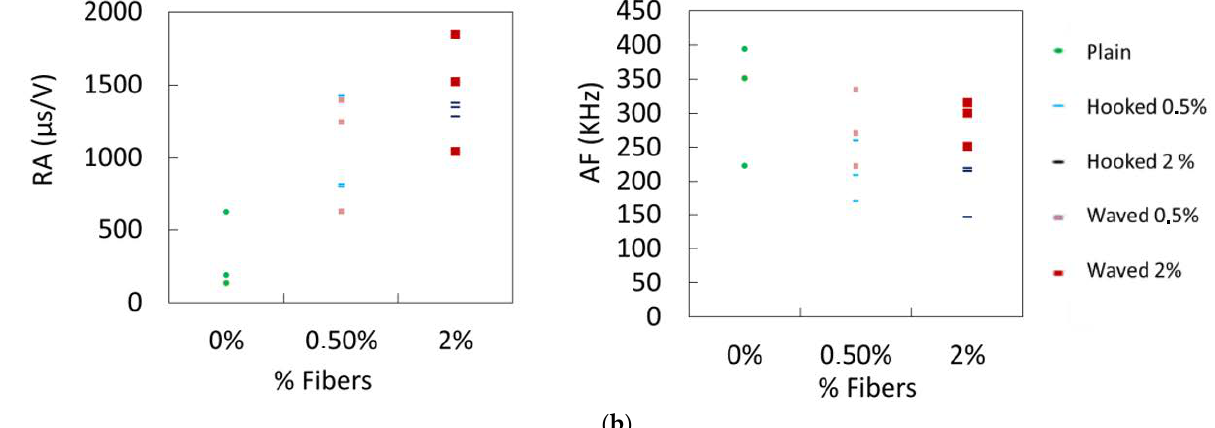
Figure 8. ( a ) RA value and ( b ) average frequency AF vs. steel fiber content for different fiber shapes.